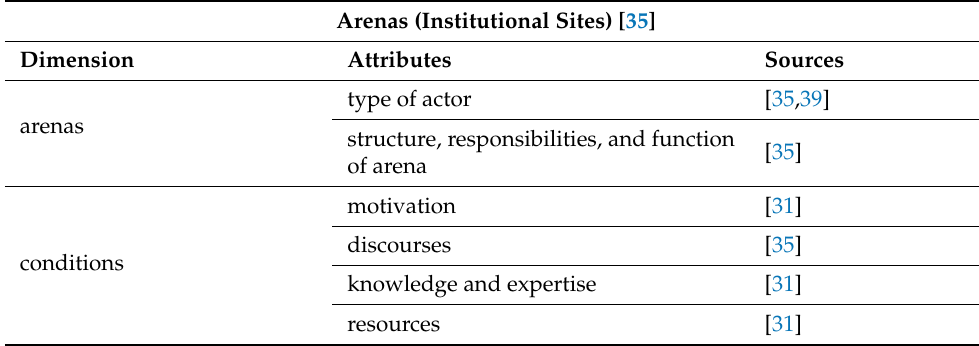
Table 1. Conceptual framework for the analysis of planning arenas.